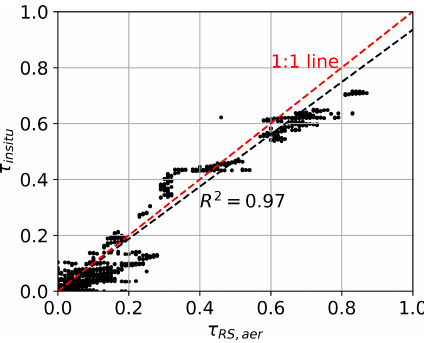
Figure 9. Comparison of τ RS,aer vs. τ insitu from the CAMP 2 Ex